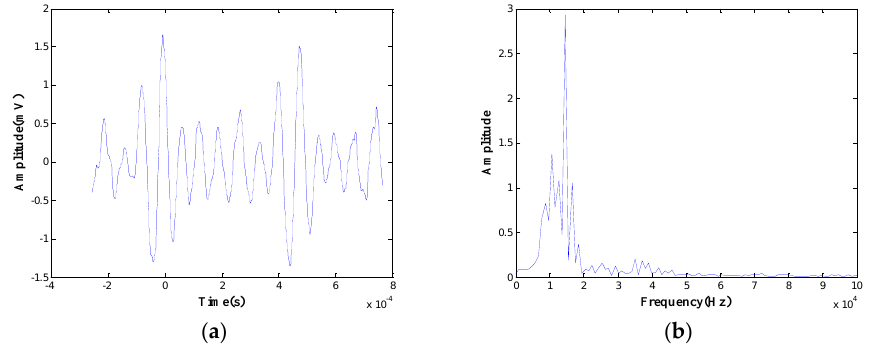
Figure 10. The waveform diagram and the spectrogram diagram of one hit: ( a ) the waveform diagram; ( b ) the spectrogram